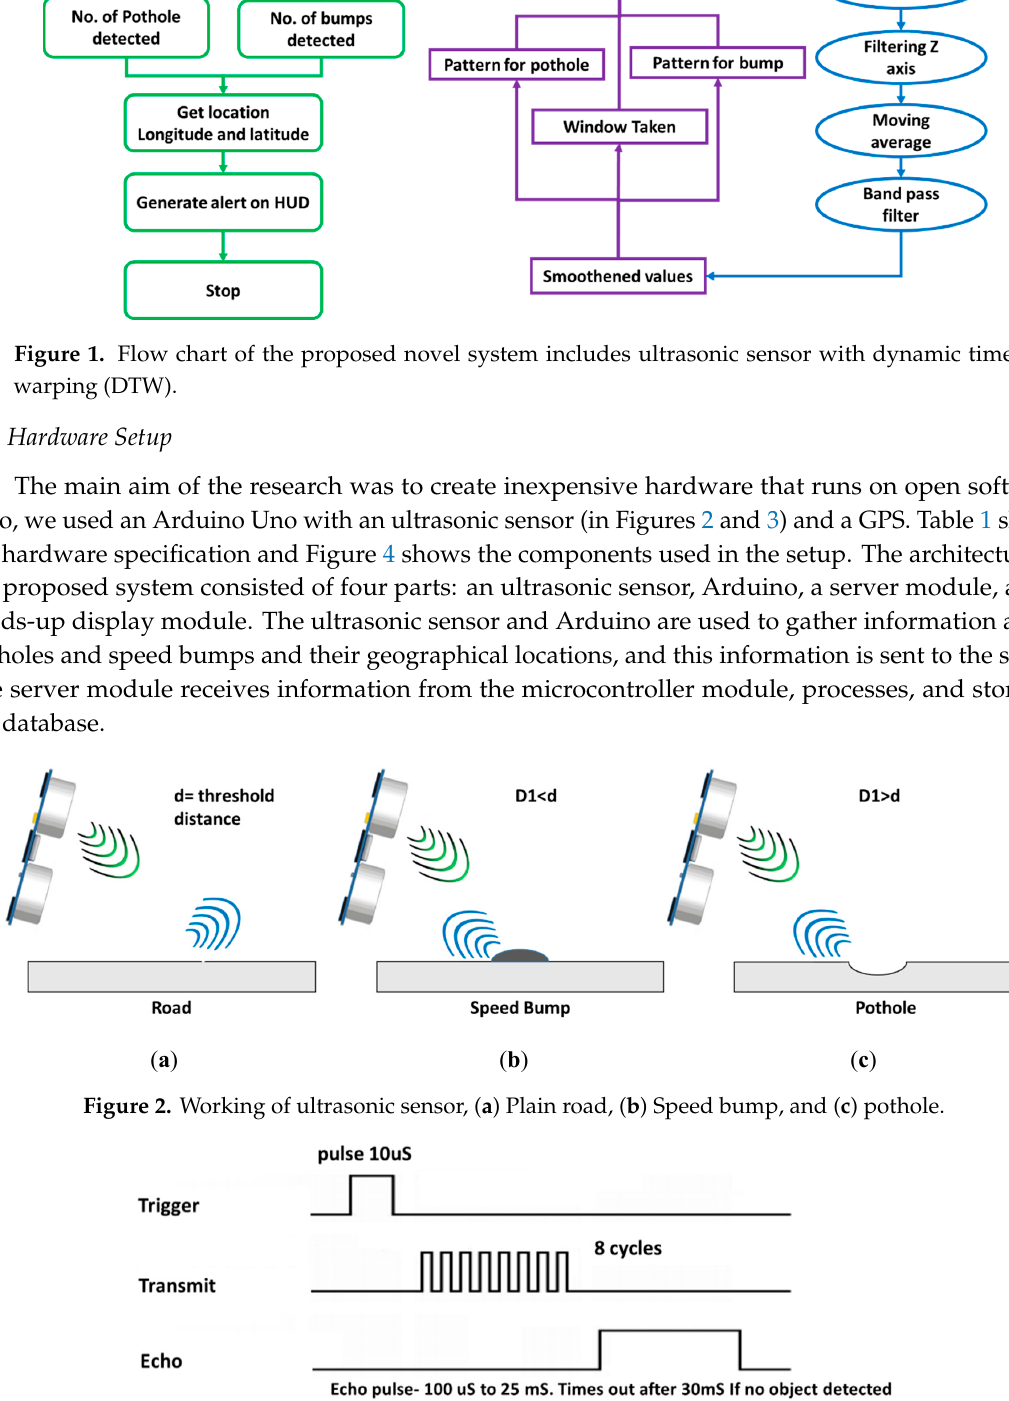
Figure 1. Flow chart of the proposed novel system includes ultrasonic sensor with dynamic time warping (DTW).